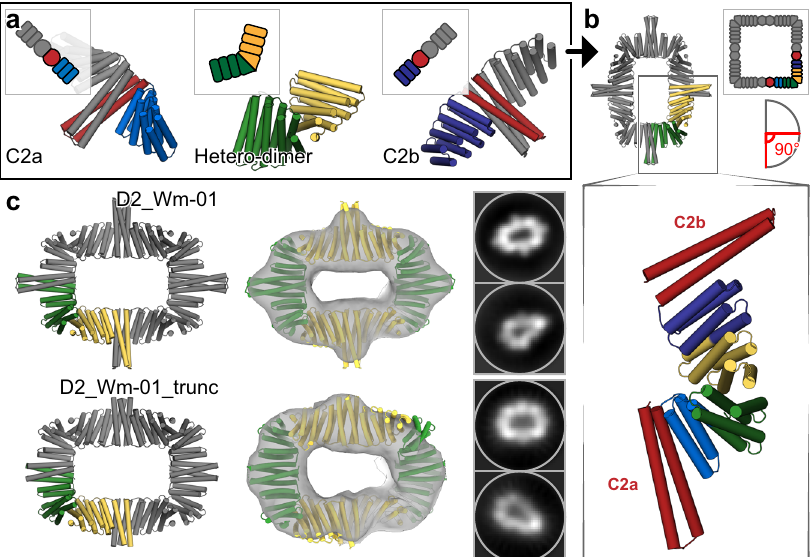
Fig. 4 Design of two-component dihedral rings. a Two different homodimeric HBs (red) with DHR extensions (shades of blue) were aligned to their respective symmetrical axes with dihedral symmetry. An additional heterodimer (green/yellow) was placed between them through architecture aware helical fusion, generating an 8-chain D2 ring. b The fi nal asymmetric unit shown in green/yellow while the inset preserves the original colors. c Negative- stain EM followed by 2D average and 3D reconstruction of D2_Wm-01 and D2_Wm-01_trunc show that the major features of the designs were recapitulated (left) designed model, (middle) overlay of the designed models with the 3D reconstructions, (right) 2D